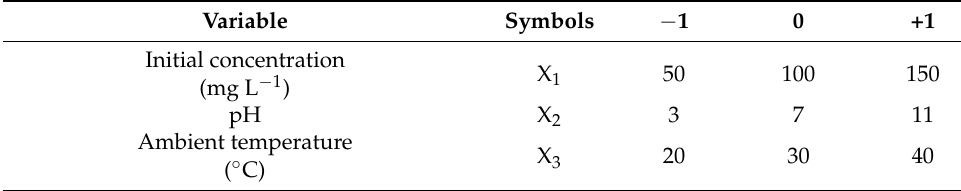
Table 4. Experimental factors and level used in the